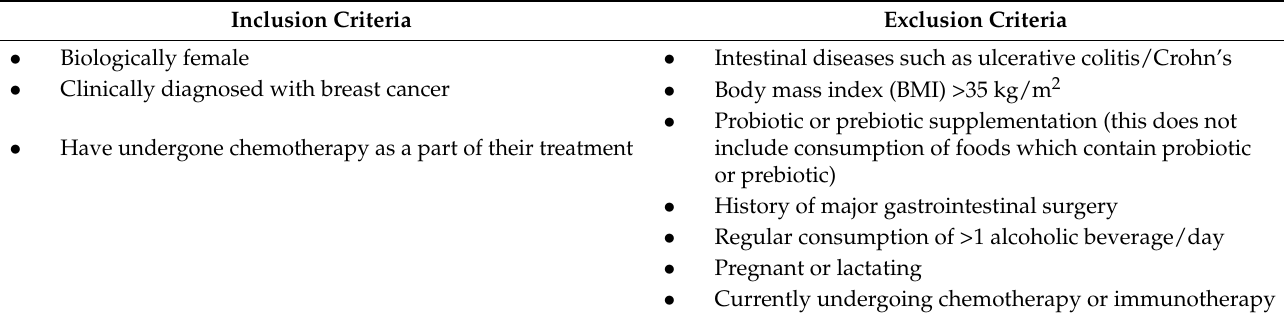
Table 1. Inclusion and Exclusion Criteria for